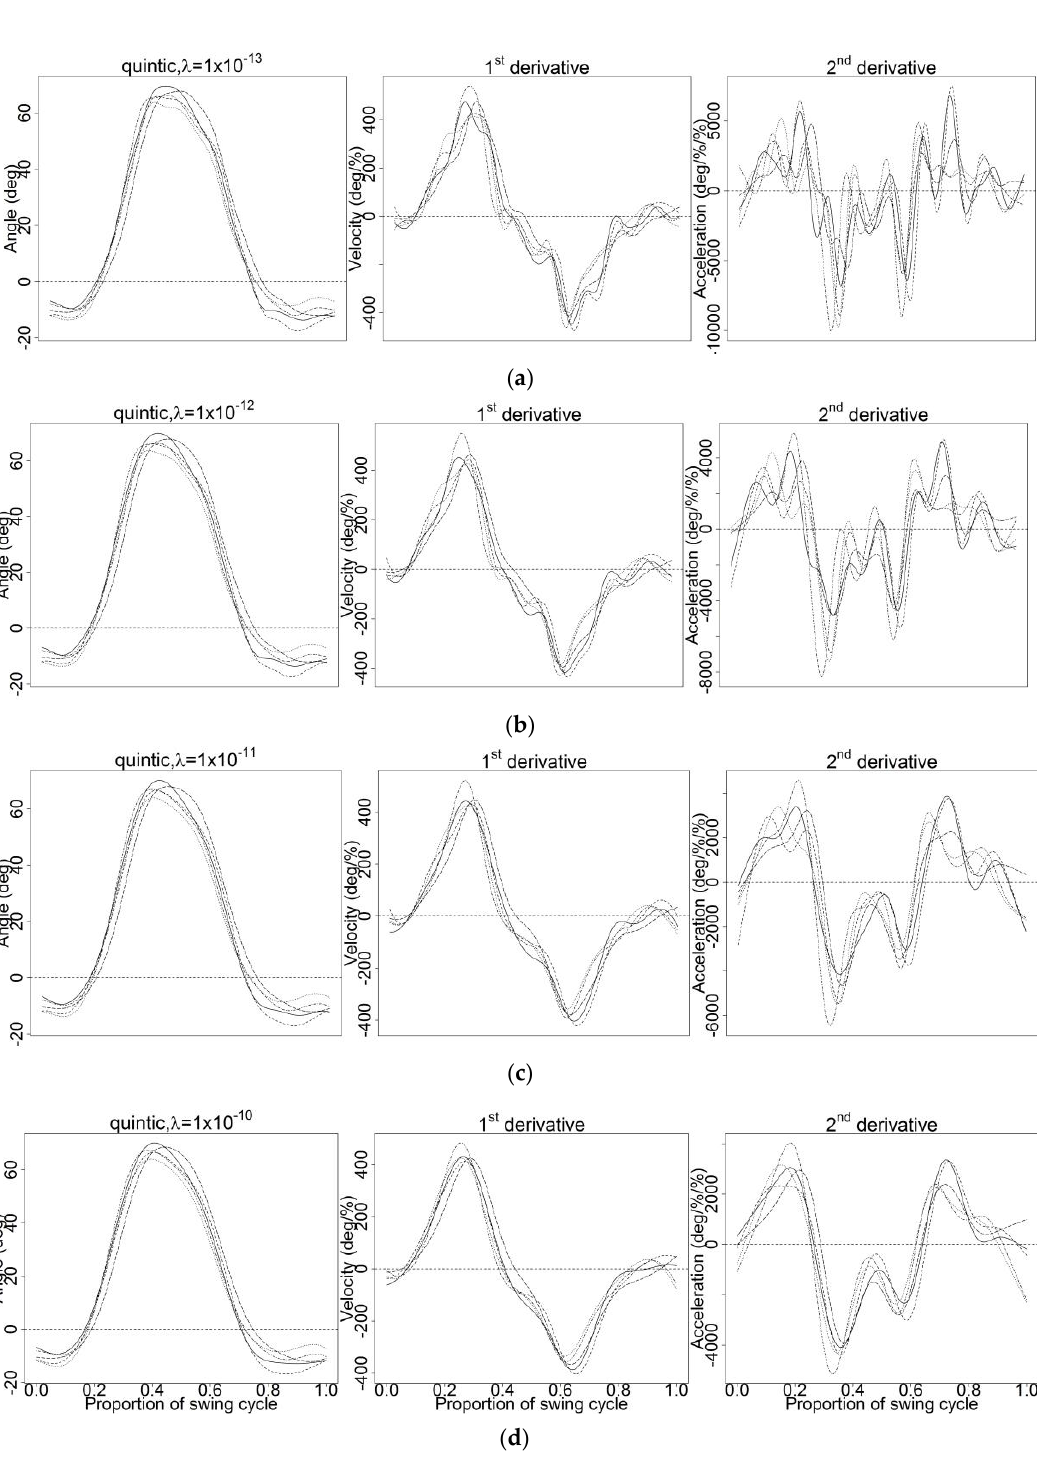
Figure A3. Smoothing using cubic spline basis with various values of